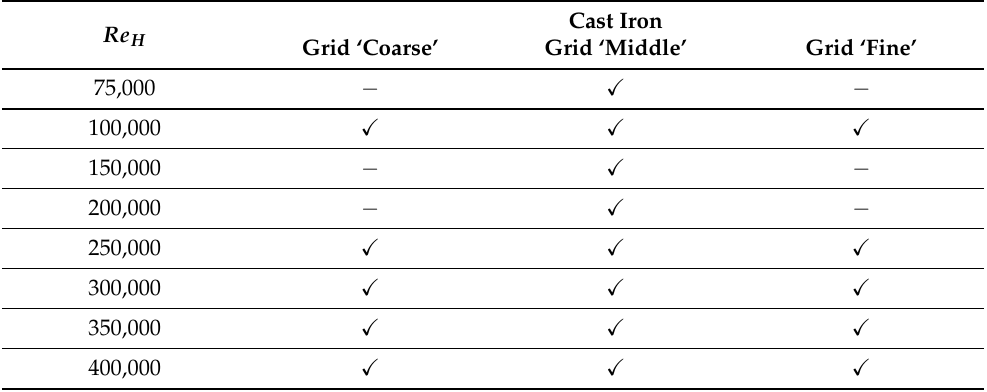
Table 4. Overview of the performed DPM simulations for the channel flow simulation with the cast iron